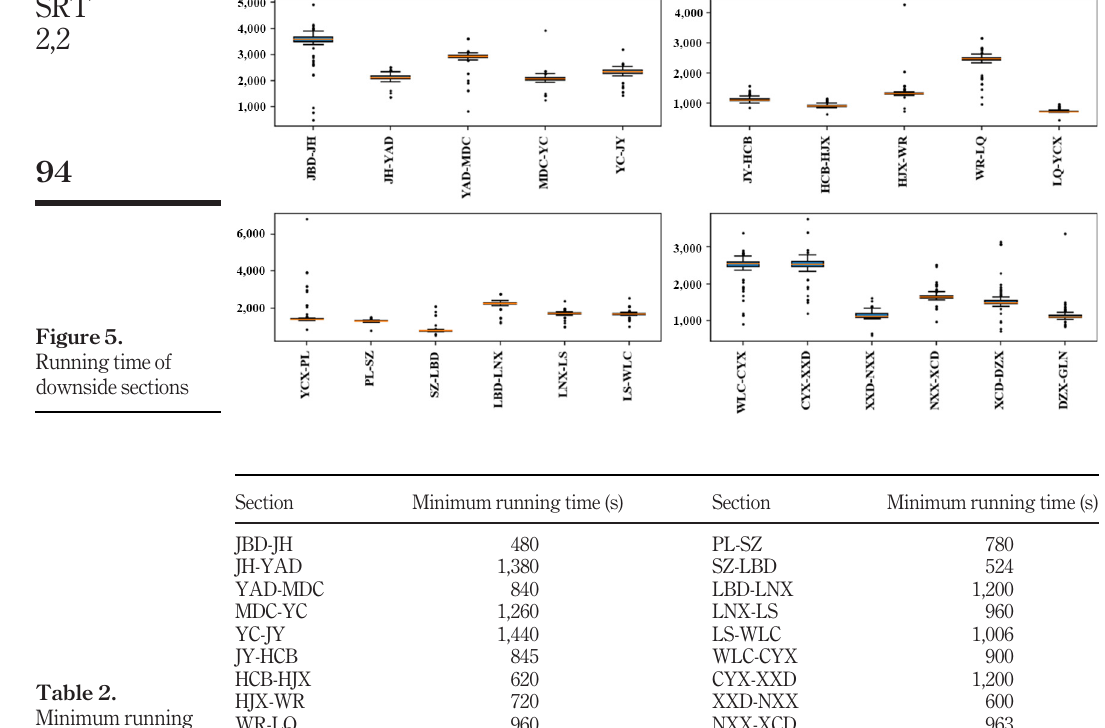
Table 2. Minimum running time of each downside section